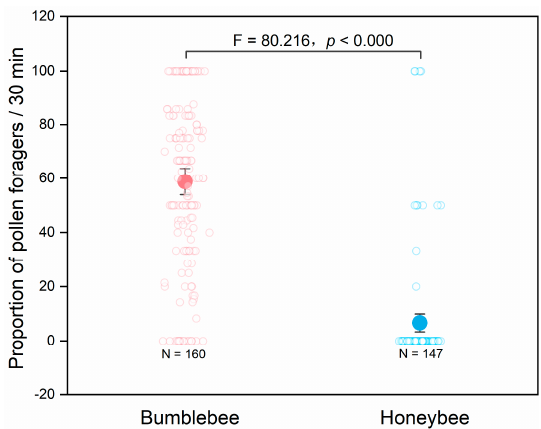
Figure 3. The proportions of pollen foragers of Apis mellifera and Bombus lantschouensis at the hive entrance in tomato greenhouses. Behavior data were obtained in six greenhouses during the tomato flowering period, and a total of 160 and 147 records were obtained for honeybees and bumblebees, respectively. Data are presented as the mean ± 95% confidence interval. A general linear repeated measure model was used to compare the proportion of pollen foragers between the two bee species.